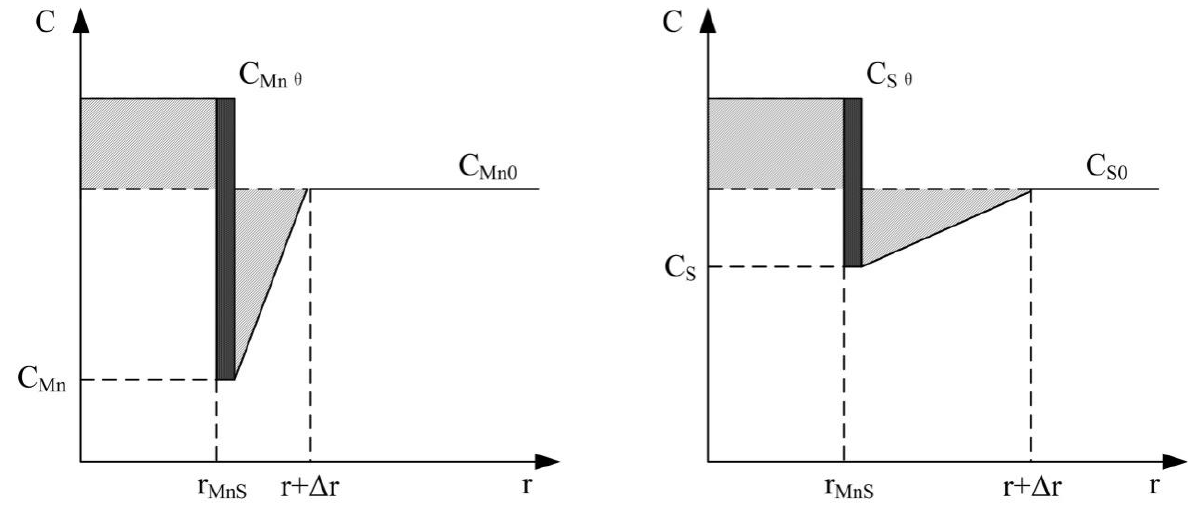
Figure 8. Calculation model of Mn and S concentrations in the γ‐ phase.